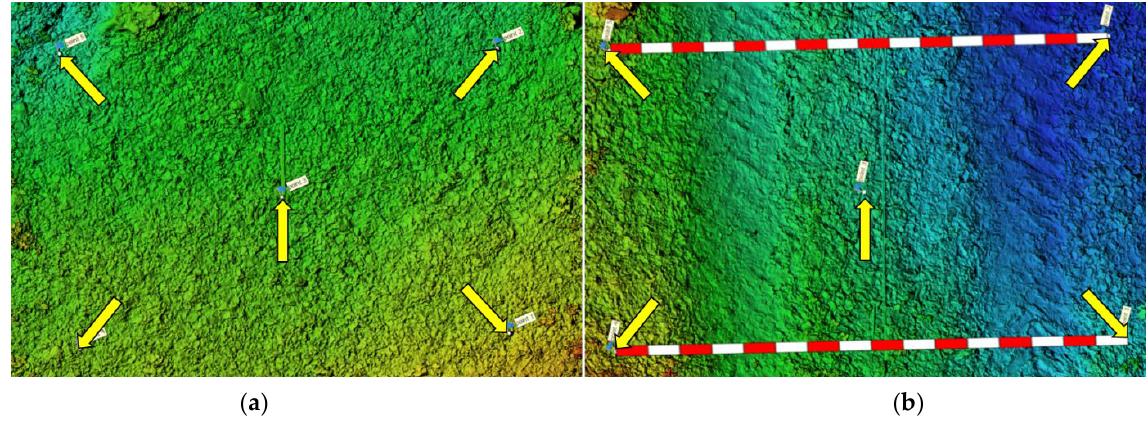
Figure 1. Surface of one sample plot with marked ground control points (yellow arrows) before the machine passes ( a ) and after 40 passes with the position of marked measuring rods ( b ) for manual measurement of the rut depths.